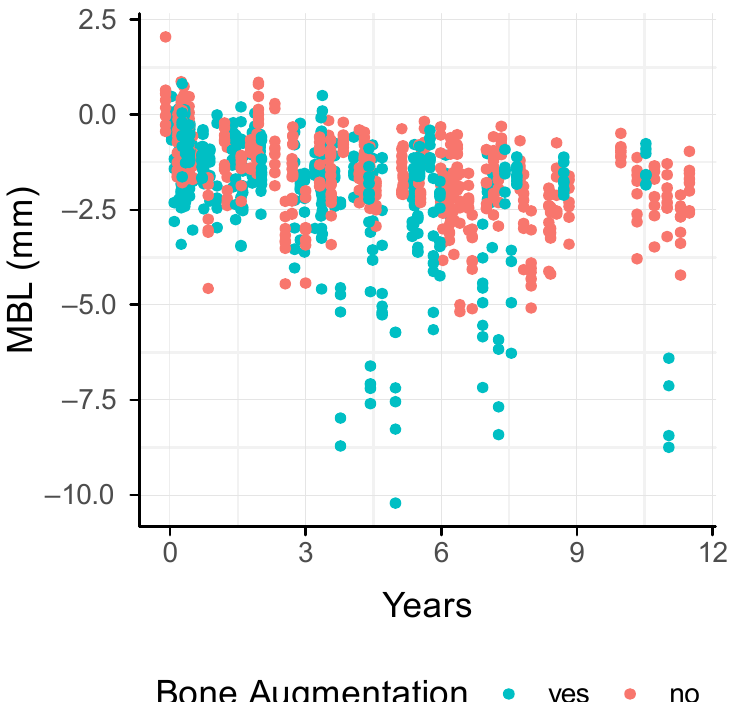
Figure 5. Trend of the marginal bone loss (MBL) of each implant over time up to 11 years of follow-up between the augmentation and the control group.